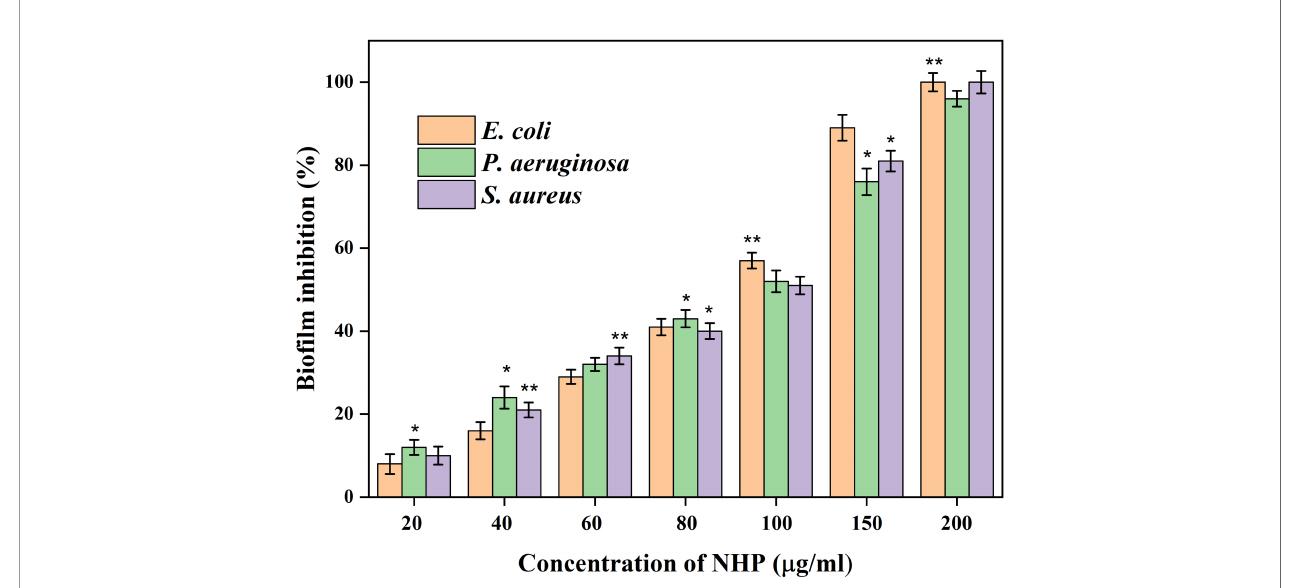
FIGURE 5 | The bio fi lm inhibitory effect of different concentrations of NHP (0 – 200 m g/ml) on 24 h old mature bio fi lm measured using crystal violet staining assay. The results were taken in triplicates and expressed as mean ± standard deviation, and the signi fi cant differences were * p < 0.05 and ** p <